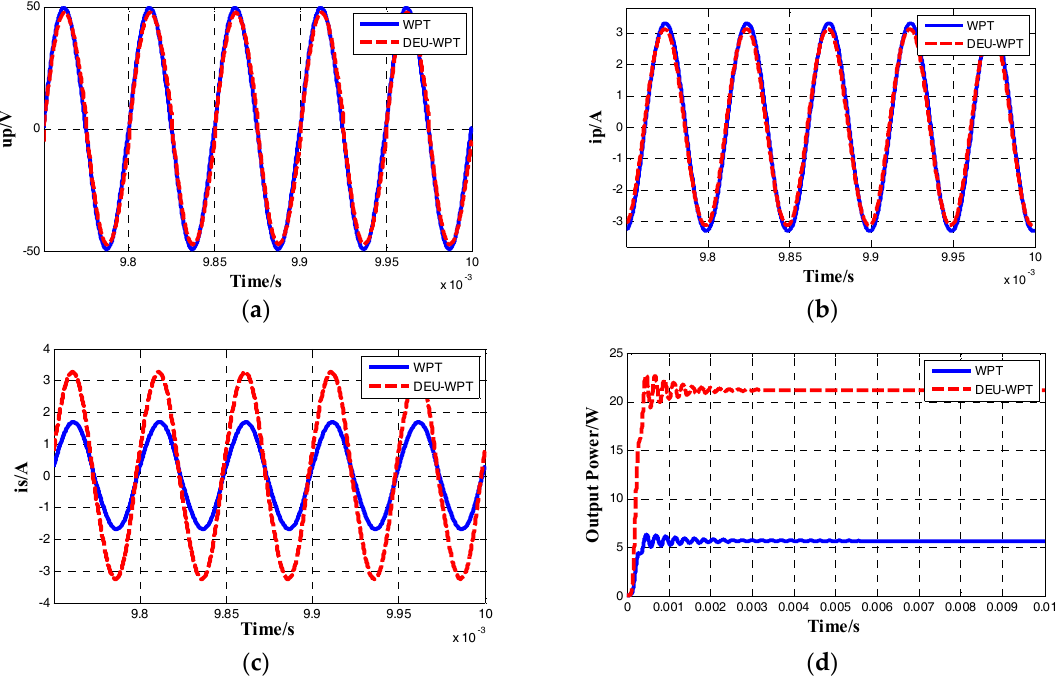
Figure 10. Comparison of simulation result: ( a ) Comparison of the primary resonant voltage of the system; ( b ) Comparison of the primary resonant current of the system; ( c ) Comparison of the secondary resonant current of the system; ( d ) Comparison of the output of the system.